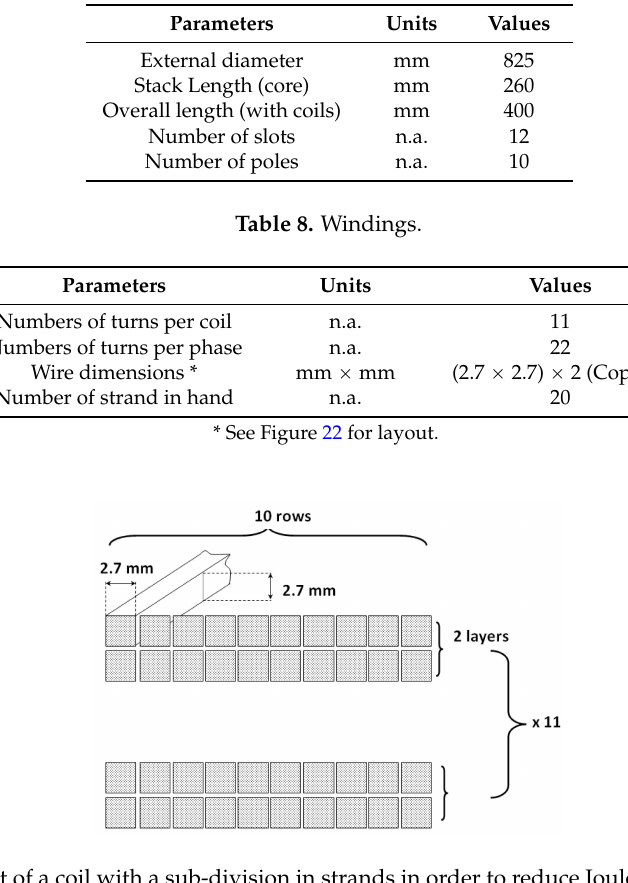
Figure 22. Layout of a coil with a sub-division in strands in order to reduce Joule losses provided by the skin effect and the proximity